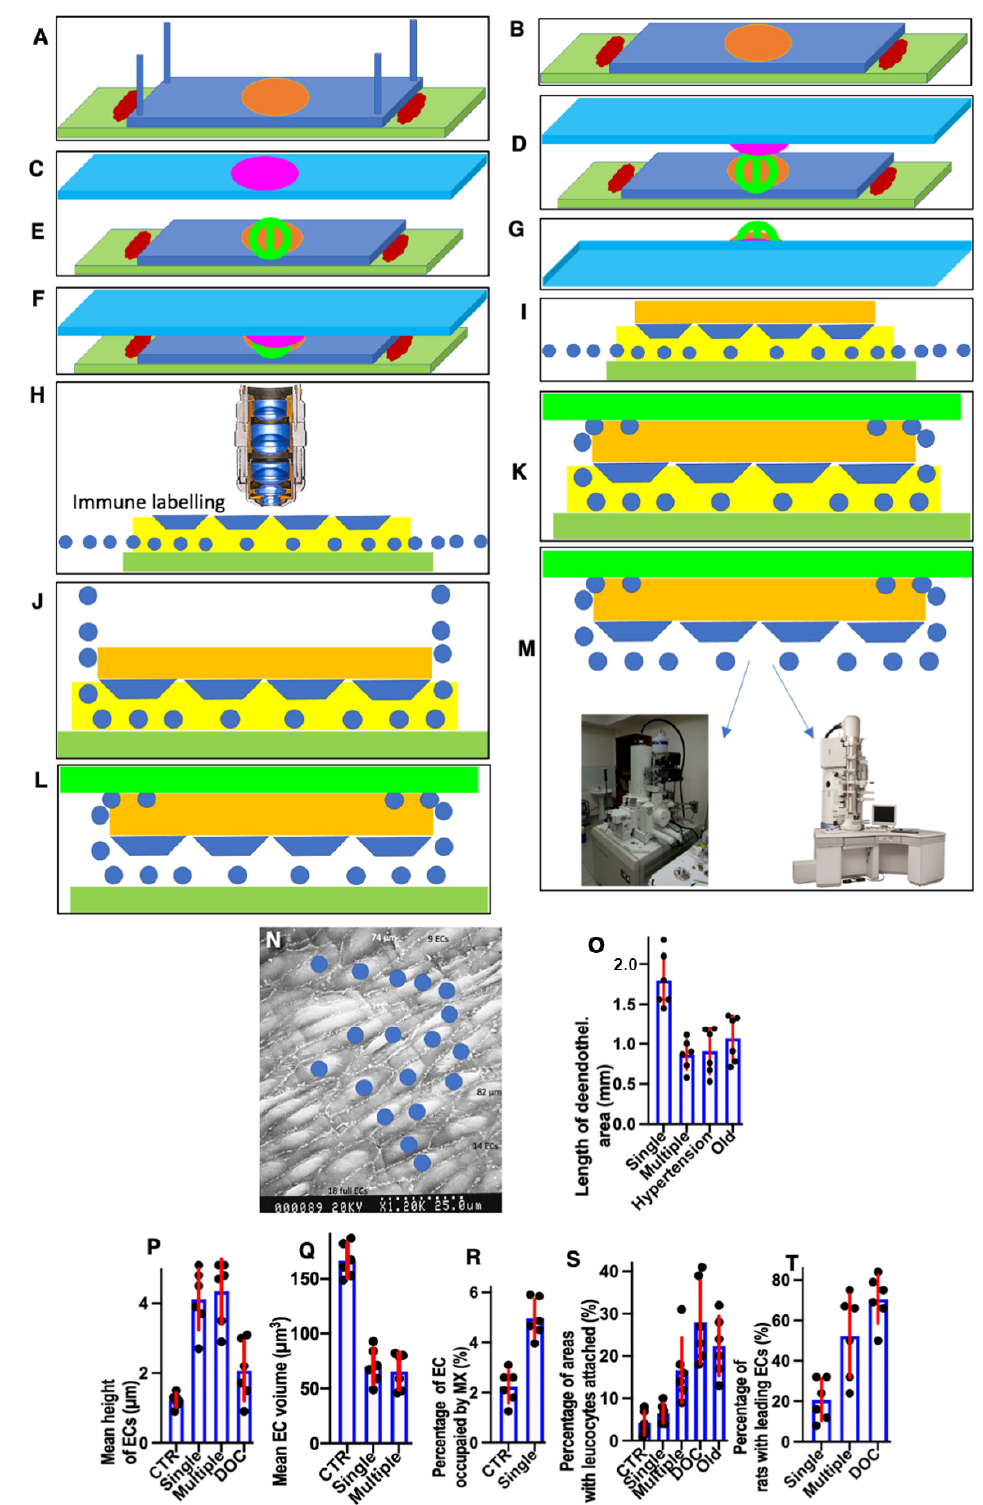
Figure 1. Scheme of the correlative light-electron microscopy of ECs on the basis of the en-face monolayer. ( A – M ) The steps of a sample preparation are described in “Material and methods” Section 2.2. ( N ) Scheme demonstrating the method of the EC counting under SEM. Example of our sampling illustrates the method of the EC volume estimation. The ECs, the border of which were not crossed by the sides of the image, are indicated with blue rings. Numbers of ECs that are crossed by the right and the upper side are indicated on the figure. The total number of ECs taken into counting is